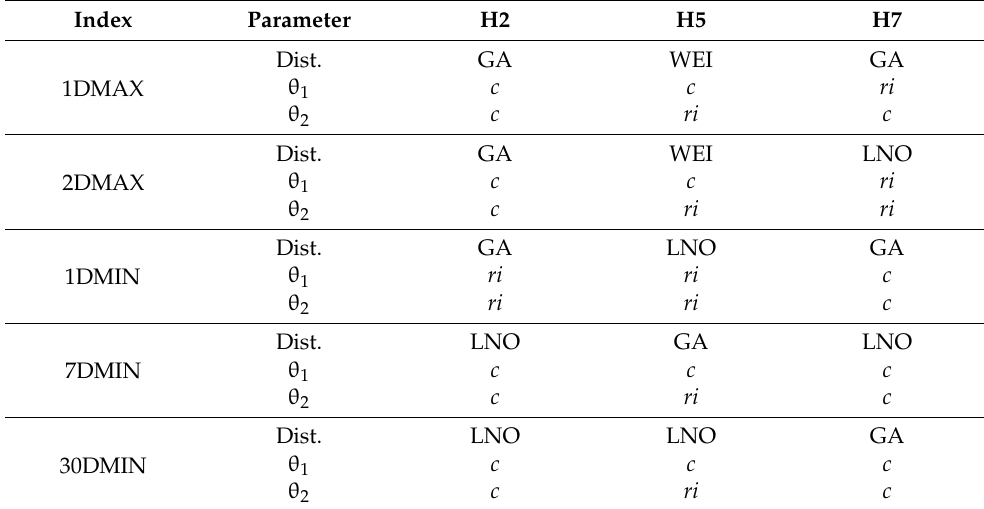
Table 8. Results of GAMLSS using RI as